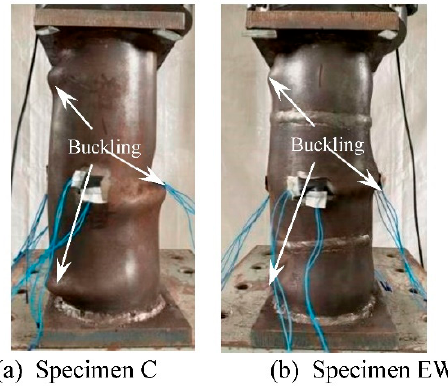
Figure 6. Failure modes of specimens without thread.